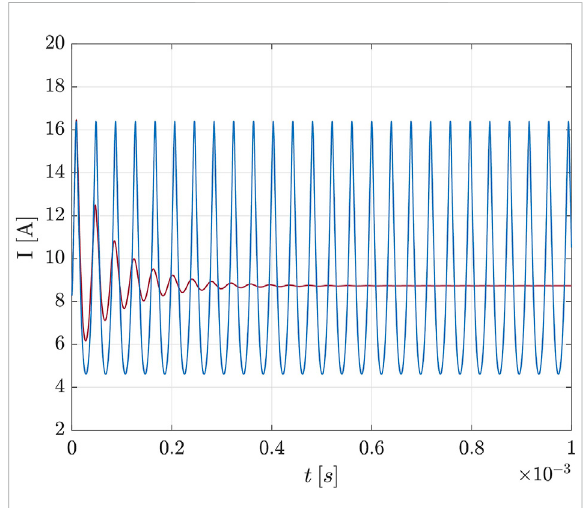
FIGURE 1 Discharge current signal of the calibrated model with (red) and without (blue) the application of the SFD